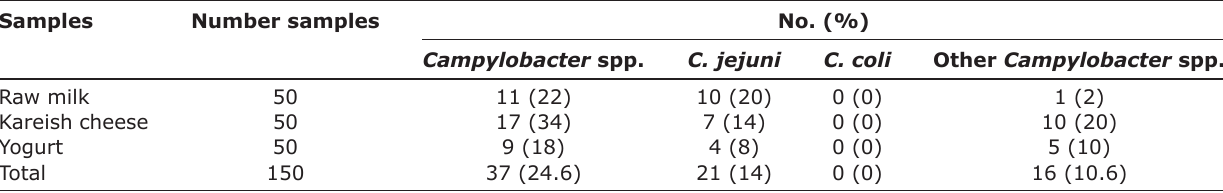
Table-2: Incidence of Campylobacter spp. in the examined samples. Samples